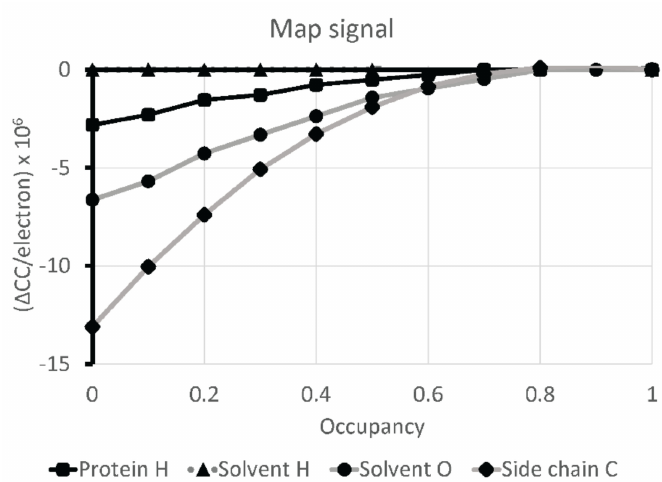
Figure 3. Signal for hydrogen atoms. As the group occupancy is changed from 1 (right) to 0 (left), the change in map-model cross-correlation coe ffi cient ( ∆ CC) is plotted, normalized per electron in the atom group. For protein hydrogens, the map has signal 1 / 4 of that expected relative to side chain carbons, while the oxygens of solvent molecules are at 1 / 2 the expected